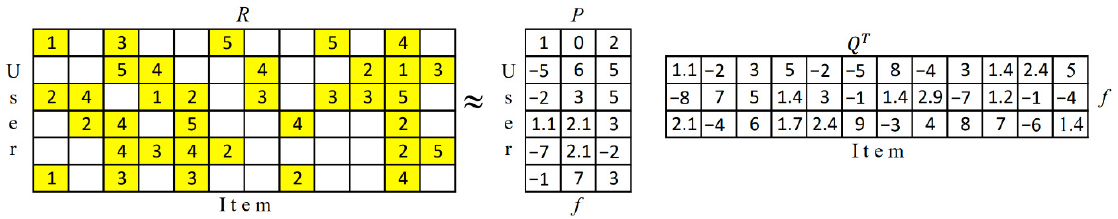
Figure 2. Decomposition of rating matrix ( R ).